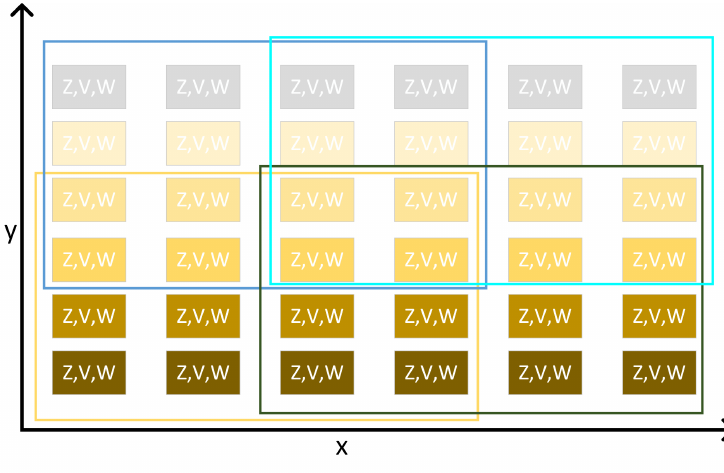
Figure A1. The calculation of intersection between adjacent